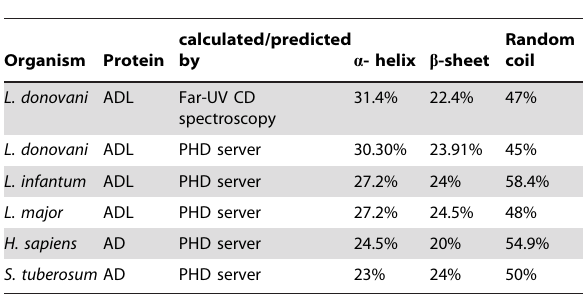
Table 1. Comparison of secondary structure composition predicted by PHD server in members of SAM-decarboxylase superfamily with far-UV CD data of L. donovani